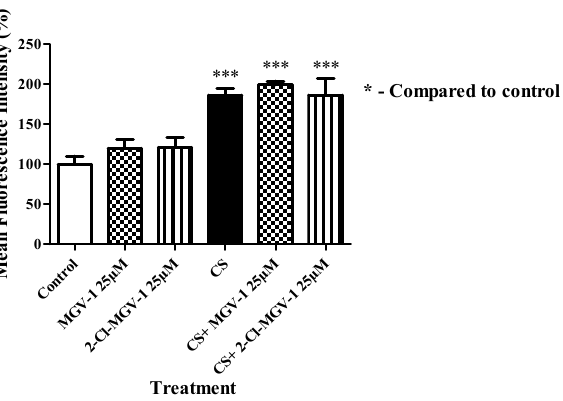
Figure 10. The impact of CS on cAMP levels with and without pretreatment with TSPO ligands in H1299 lung cancer cells. FACS was used to quantify the levels cAMP following exposure to 60 min of CS. The control, MGV-1 and 2-Cl-MGV-1 groups were exposed to fresh air only. Results are represented as mean ± SEM ( n = 3 in each group). *** p < 0.001 vs. control. CS = cigarette smoke.